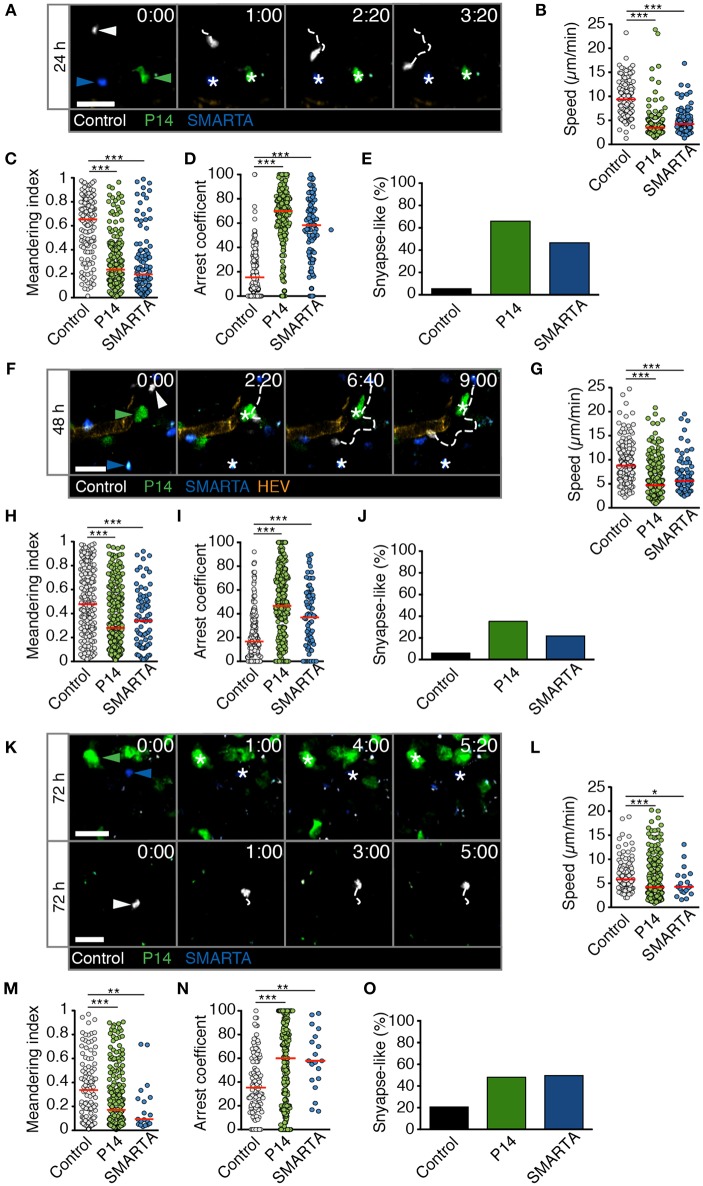
T cell motility in reactive LNs during HD LCMV infection. (A) Representative 2PM images of control (white), P14 (green), and SMARTA T cell tracks (blue) with HEV (orange) at 24 h p.i. Arrowheads point the tracked cell: control (white), P14 (green), and SMARTA (blue). Scale bar, 20 μm. (B–E) Quantification of 2PM motility parameters at 24 h p.i.: Migration speed (B), Meandering index (C), arrest coefficient (D), and percentage of synapse-like T cell motility (E) of control (gray), P14 (green), and SMARTA T cells (blue). (F) Representative 2PM images of control, P14, and SMARTA T cells with HEV (orange) at 48 h p.i. as in (A). Arrowheads point the tracked cell and * indicate arrested T cells. Scale bar, 20 μm. (G–J) Quantification of 2PM motility parameters at 48 h p.i.: Migration speed (G), Meandering index (H), arrest coefficient (I), and percentage of synapse-like T cell motility (J) of control (gray), P14 (green), and SMARTA T cells (blue). (K) Representative 2PM images of control, P14, and SMARTA T cells with HEV at 72 h p.i. as in (A). Arrowheads point the tracked cell and * depict arrested T cells. Scale bar, 20 μm. (L–O) Quantification of 2PM motility parameters at 72 h p.i.: Migration speed (L), Meandering index (M), arrest coefficient (N), and percentage of synapse-like T cell motility (O) of control (gray), P14 (green), and SMARTA T cells (blue). Red lines depict median. Each dot represents a single track. Data are pooled from five independent experiments with four mice (24 h), six mice (48 h), and eight mice (72 h). Statistical significance was analyzed by unpaired Mann-Whitney test of control vs. P14 and SMARTA T cells, respectively. *p < 0.05; **p < 0.01; ***p < 0.001.